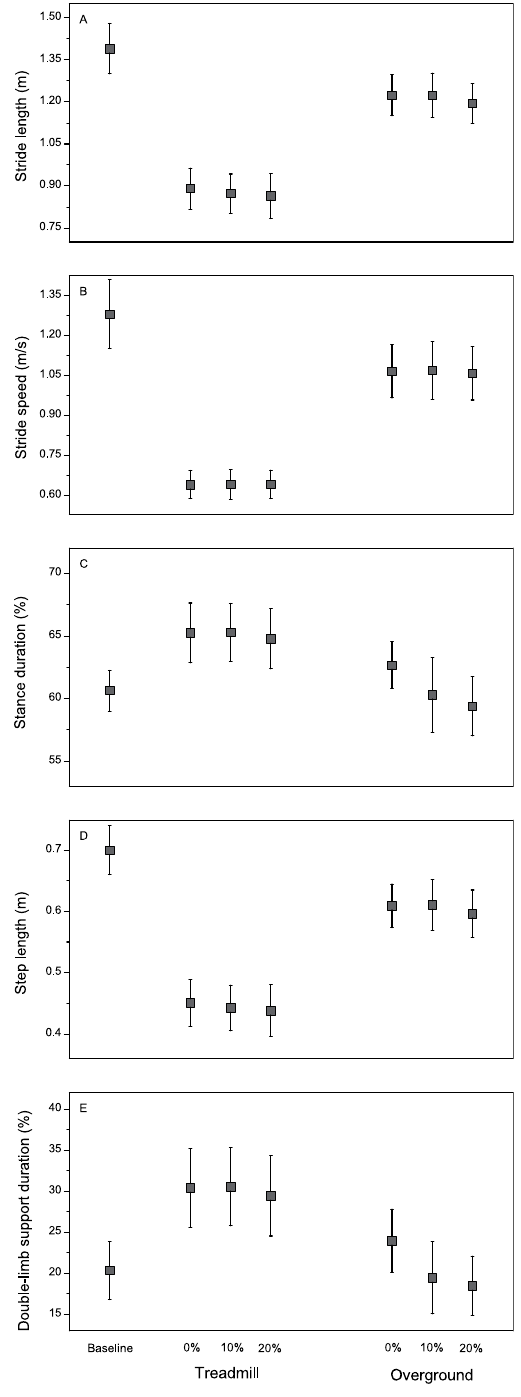
Figure 1. Mean and standard deviations of stride length ( A ), stride speed ( B ), percentage of stance duration ( C ), step length ( D ), and percentage of total double-limb support ( E ) at the baseline, 0%, 10%, and 20% of BWS on both treadmill and over the ground. Note: data from baseline are presented only as reference